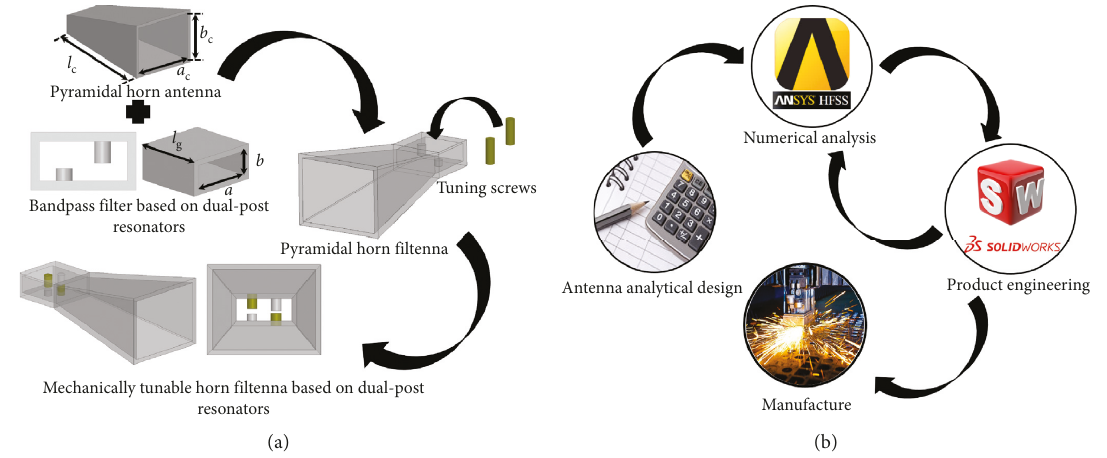
Figure 1: Horn filtennas design (a) and development methodology